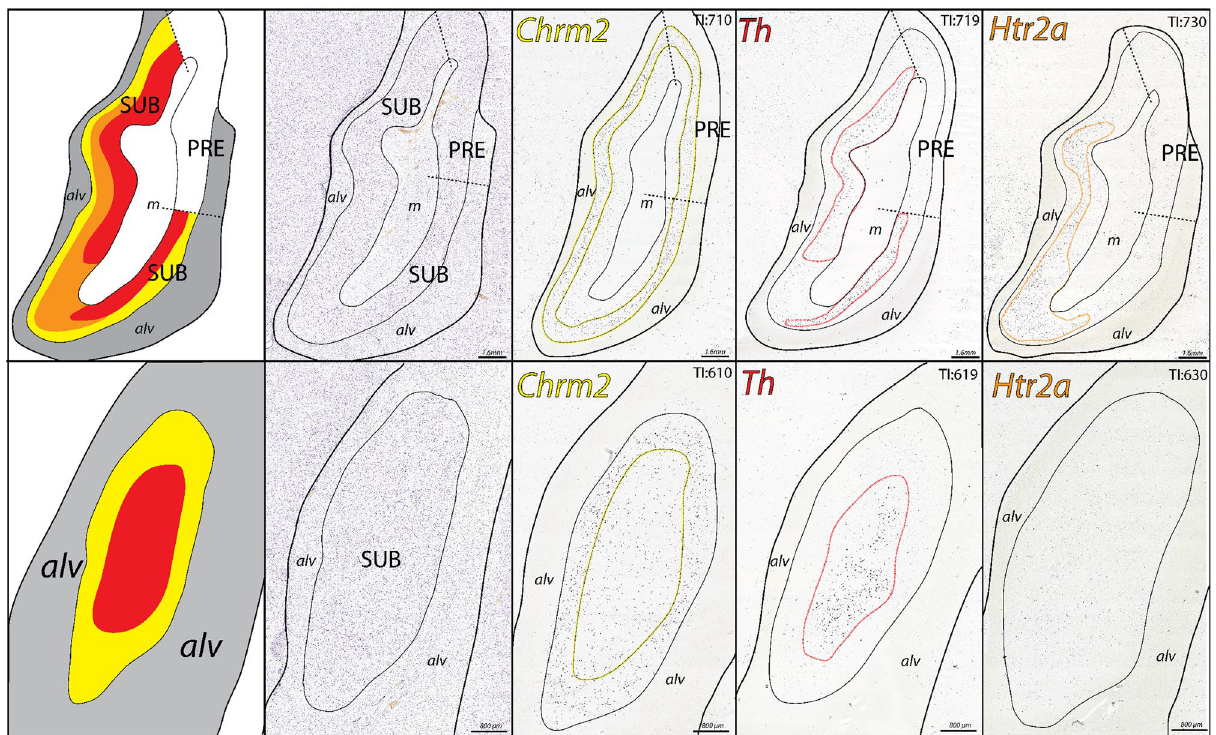
Figure 5. Gene expression patterns at the SUB anterior tip. (top row) 4 mm anterior to the section shown in Fig. 4, the CA1 is no longer present and the ventral and dorsal regions of the SUB become continuous along with their laminar gene expression patterns. In situ hybridization images of Chrm2 , Th , and Htr2a expression (colored outlines) are presented with adjacent Nissl and corresponding atlas drawings. Chrm2 -expressing cells form a continuous external layer adjacent to the alveus (alv), whereas Th and Htr2a expression is distributed within cells located more internally near the molecular layer (m). Unlike the tissue level shown in Fig. 4, there is abundant Th expression in the more dorsal part of the SUB. In the most anterior coronal section (bottom row, 2 mm anterior to sections shown in top row), the molecular layer is no longer present. Chrm2 -expressing cells form a continuous ring layer that surrounds a core of Th expressing cells (few Htr2a expressing cells remain at this level). Together this data shows that Chrm2 , Th , and Htr2a expressing cells form three distinct layers that wrap continuously around the anterior/medial tip of the hippocampus. In relation to the section in Fig. 4, the layer of Th expression appears to end dorsally approximately ~ 6 mm from the anterior pole of the SUB, whereas Chrm2 and Htr2a expression continues posteriorly within the dorsal part of the anterior SUB. ). All Nissl and in situ hybridization images downloaded from www.brain hippocampus sections in humans would most directly relate to horizontal sections in the mouse and vice versa. However, several key aspects of SUB organization can be understood even comparing tissue that is sectioned at different angles relative to the longitudinal axis. In both mouse dorsal SUB and human posterior SUB, Nts is strongly expressed in a superficial layer of SUB pyramidal neurons closest to the molecular layer, whereas Chrm2 -expressing neurons are primarily located in the deepest part of the SUB, forming a continuous layer adjacent to the alveus white matter tract (Fig. 7a). Note that the position of the alveus and molecular layer are switched dorsoventrally in mouse vs. human tissue. This data suggests that the superficial SUB layer in humans (containing Nts- and Th- expressing neurons) is directly homologous to SUB sublayer 1 in the mouse HGEA, whereas the Chrm2-expressing deep layer in humans is homologous to mouse SUB sublayer 4. Therefore, Htr2a -expressing human SUB neurons likely correspond to the other two mouse SUB layers 2 and 3. However, Htr2a expression appears almost entirely absent in the mouse CA1 and SUB and other genes that are present in both mouse and human SUB (ex. Pcp4 ) are expressed in dif- ferent combinatorial patterns (Fig. 7b). Overall, annotation of gene distribution within the SUB layers of both mouse and human subiculum suggests similarities and differences in combinatorial gene expression distribu- tion (Supplementary Table 2). Together, this data suggests that while the anatomical laminar organization is evolutionarily conserved between mice and humans, there exists both conservation and divergence of the gene expression profile for each SUB layer and their unique cell types. Although visualizing overall structure from thin-cut tissue sections can be difficult, the relationship of mouse and human SUB is easier to visualize in 3D and we have generated a model of the human SUB based on our understanding of the changes to the mouse SUB (Fig. 8a). In addition to the rotation of the longitudinal axis, one end of the hippocampus structure (the anterior pole in human corresponding to ventral pole in mouse) has folded back against the longitudinal axis. In comparison, the mouse and human SUB laminar organization